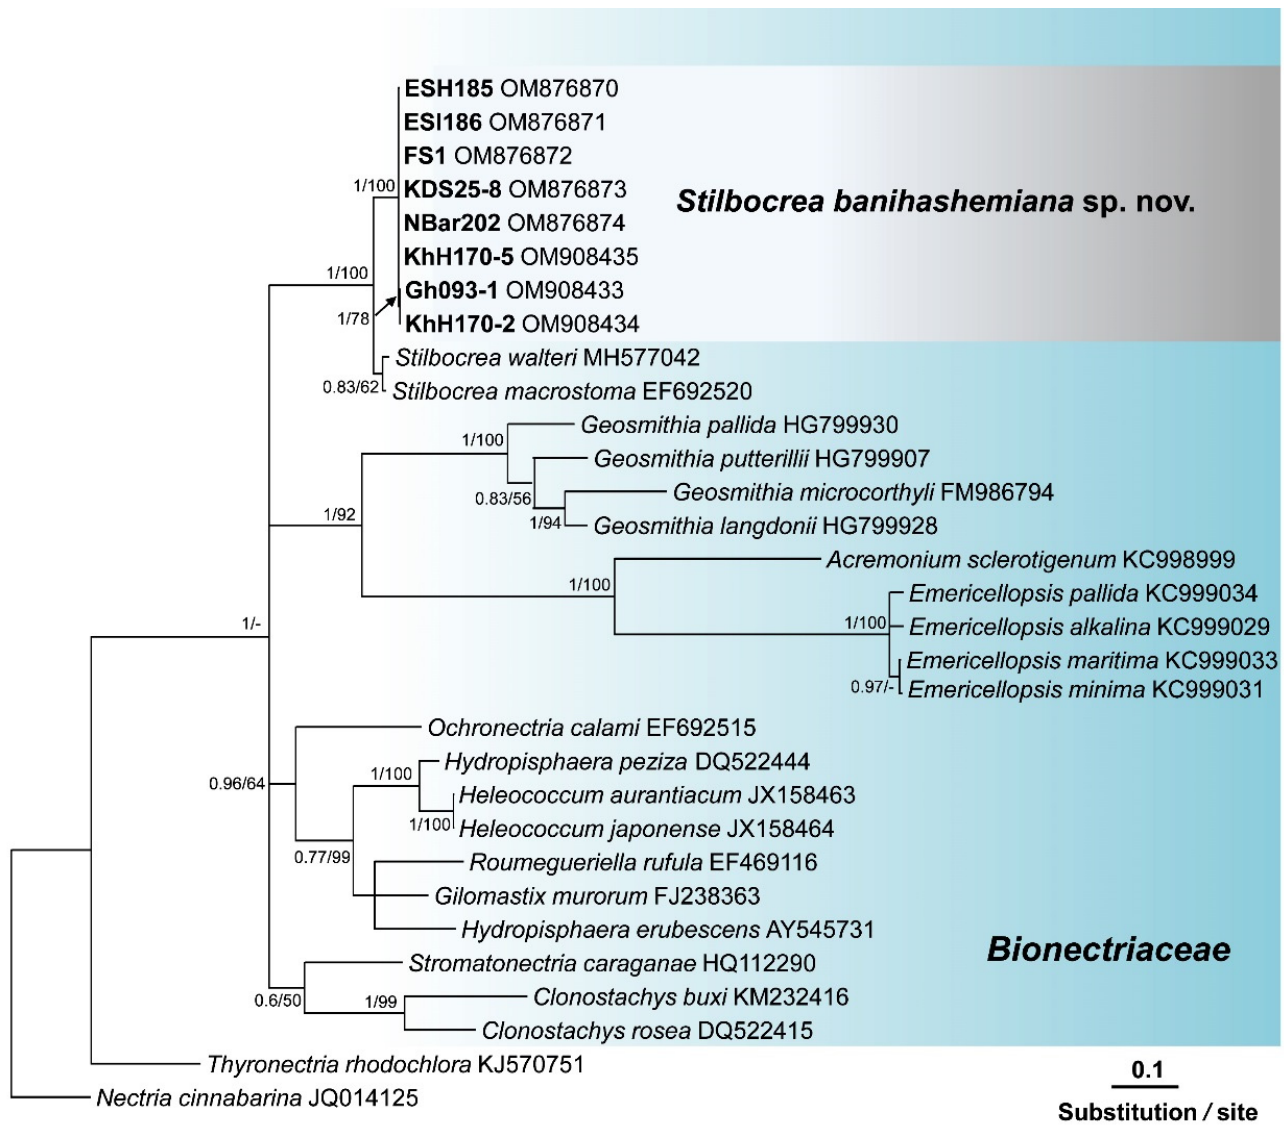
Figure 4. Phylogenetic position of Stilbocrea banihashemiana sp. nov. from infected fig and loquat trees sampled in Fars Province, Iran within Bionectriaceae : relationships among 21 Bionectriaceae members based on Bayesian analysis of rpb2 (the second largest subunit of RNA polymerase II) sequences. Isolates in bold were sequenced in the present study. Numbers on the nodes are Bayesian posterior probability values (BI–PP) followed by maximum likelihood bootstrap values (ML–BS), Full supported branches (BI–PP = 1/ML–BS = 100). The tree was rooted to two Nectriaceae members, Nectria cinnabarina and Thyronectria rhodochlora , FS1 = ex-type = CBS 148864. Isolates recovered from infected fig, and loquat trees in Iran are indicated in bold . Arrow represents the exact position of supporting values in the phylogenetic tree.